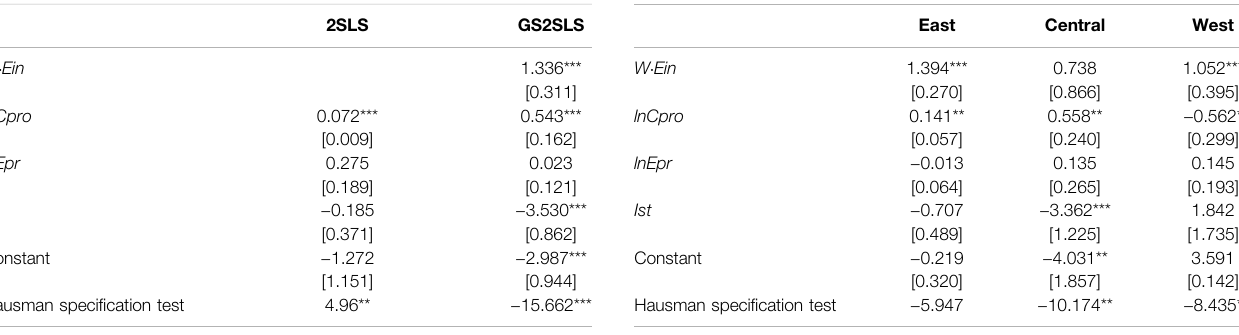
TABLE 9 | Impact mechanism of coal production on energy intensity using 2SLS and GS2SLS.